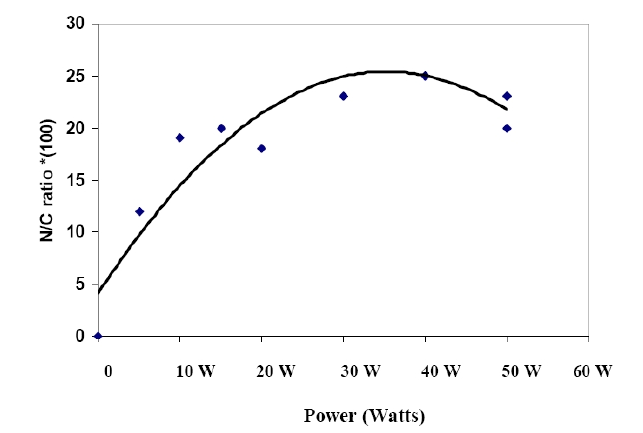
Fig. 4 RF- power effect on surface N/C atomic ratio